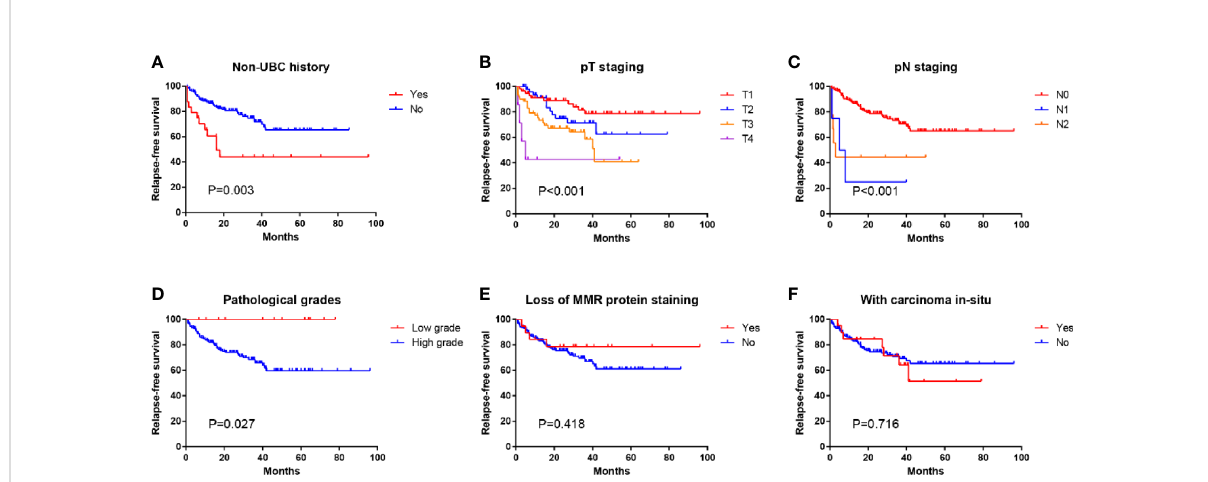
FIGURE 2 Kaplan – Meier analysis of relapse-free survival of patients with different (A) non-UBC history, (B) pT staging, (C) pN staging, (D) pathological grades, (E) MMR protein staining status, and (F) carcinoma in situ